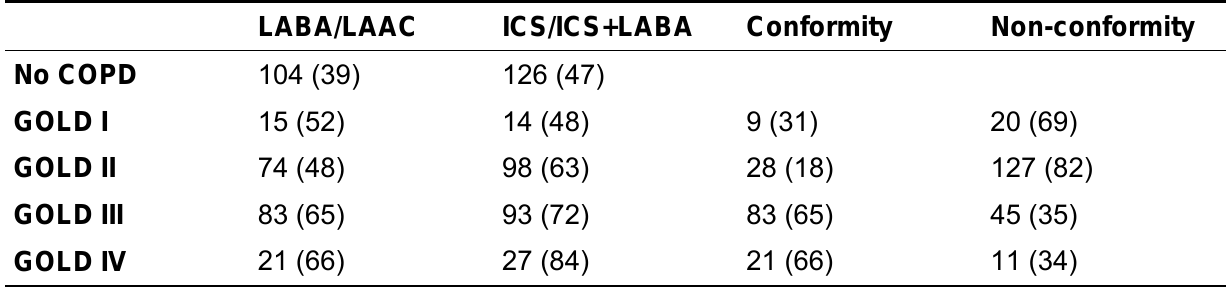
Assessment of conformity to GOLD recommended use of long-acting bronchodilators and